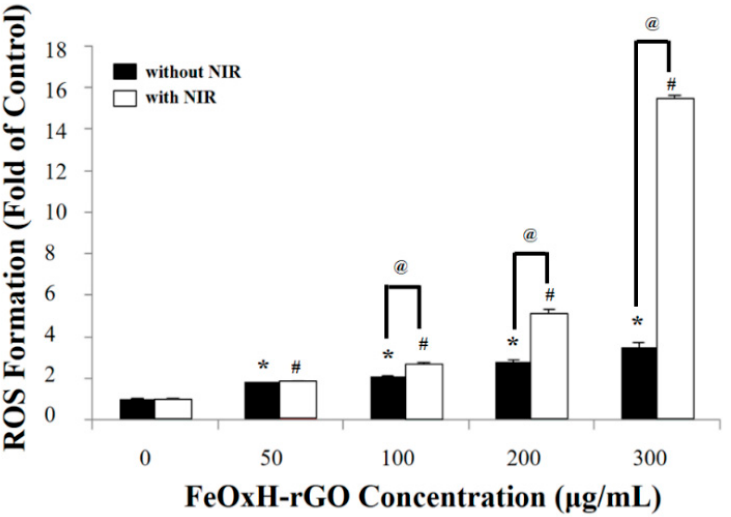
Figure 3. Photodynamic properties of FeOxH–rGO nanocomposites. ROS formation of FeOxH–rGO (0–300 µ g/mL) with or without NIR illumination (880 nm, 2.72 W/cm 2 ). * p < 0.05 and # p < 0.05 indicate statistically significant differences from the control (0 μ g/mL). @ p < 0.05 indicates statistically significant differences from FeOxH–rGO-treated T47D cells without NIR illumination.